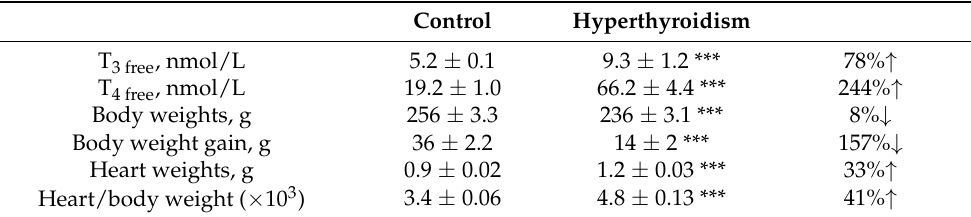
Table 1. Thyroid hormone concentrations and morphometric parameters in control and hyperthyroid